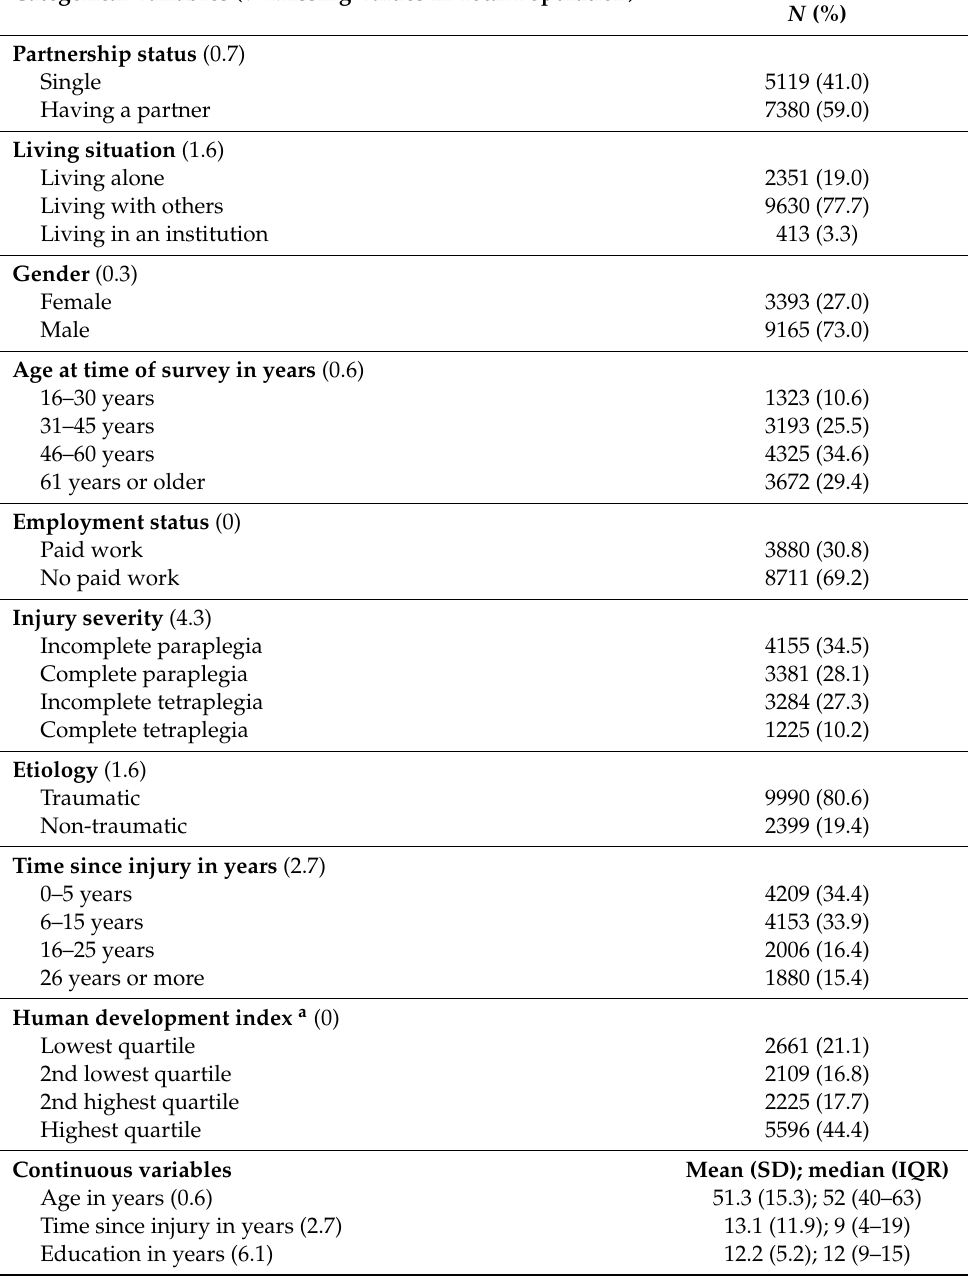
Table 1. Basic characteristics of the 12,591 International Spinal Cord Injury (InSCI) community survey